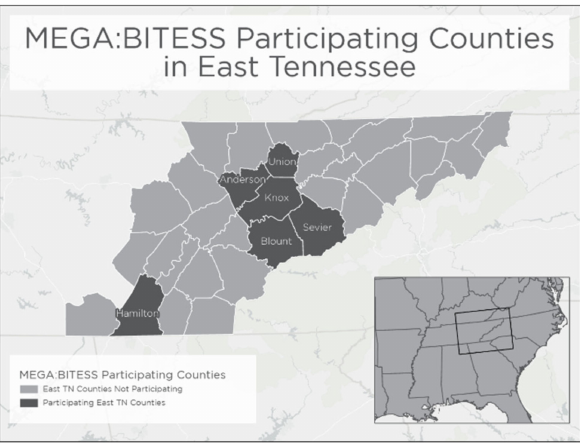
Figure 1. Educators from six counties in eastern Tennessee participated in two years of the program.